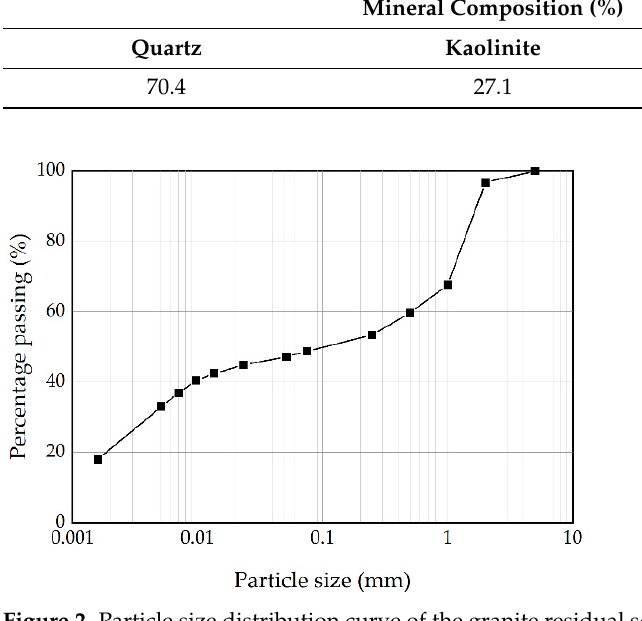
Figure 2. Particle size distribution curve of the granite residual soil.